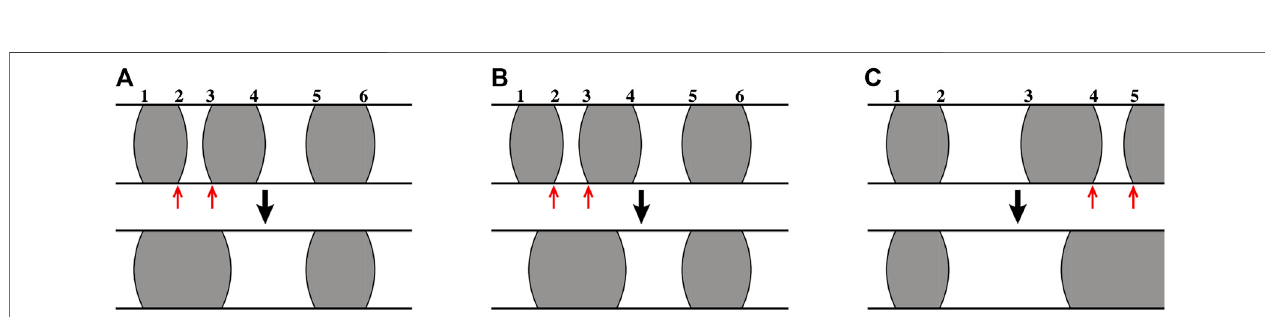
FIGURE3| Thethreeintermediatestepsforthemeniscusdynamics,themeniscus_move,meniscus_createandmeniscus_merge,ateverytimestepareillustrated here.Here fi velinks,numberedas j (cid:1) 1,2,3,4and5,areconnectedtothenode i .Howevertheaboveillustrationsarealsovalidforanynumberoflinks.Wettingandnon- wetting fl uidsinsidethelinksarecoloredbywhiteanddarkgrayrespectively.Alloftheporespacearedistributedtothelinksinthismodelandtheareaaroundthenode i , colored by light gray, does not contain any real volume. (A) shows an example con fi guration of two fl uids at a time step. Solution of the Kirchhoff equations as describedin Section2 providesthelocal fl owrates q j .Basedonthedirectionsof q j atthistimestep,saythelinks1,2and3areidenti fi edastheincominglinkswhereas4 and 5 are identi fi ed as the outgoing links here. Values of the displacements Δ x j for each link, calculated from Δ x j (cid:1) q j Δ t / a j (see text) are shown by dashed lines. Every meniscusinalink j aremovedtoward(intheincominglinks)orawayfrom(intheoutgoinglinks)thenodebyadistance Δ x j whichisshownin (B) .Thisisperformedbythe function meniscus_move. The total volume of the fl uids ( a 1 Δ x 1 + a 2 Δ x 2 + a 3 Δ x 3 ) which left the links 1, 2 and 3 into the node i is now to be placed at the beginning of the links4and5,whichwill fi llthevolume ( a 4 Δ x 4 + a 5 Δ x 5 ) andwillcreatenewmenisciintheoutgoinglinksasdescribedinmeniscus_create.Therearetwodifferentwaysof creatingthenewmenisci,oneistoplacethewetting fl uid fi rstandthenon-wettingnextasshownin (C) ,andtheotheristoplacethenon-wetting fl uid fi rstandthewetting next as shown in (D) . We adopt (C) and (D) alternatively at each consecutive time steps. (E) shows the meniscus_merge function for the link 5 when there are four allowed menisci. There link 5 has total six menisci before merging and the two bubbles around the two nearest menisci marked by the arrows are merged. The merging process are illustrated in more detail in Figure 4.